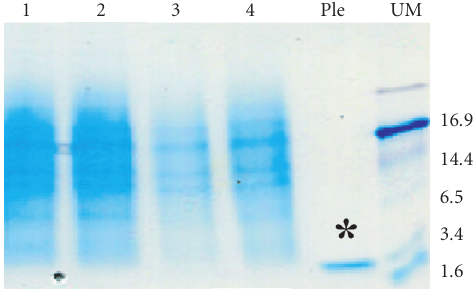
Figure 8. Western blot of synthetic pleurocidin (Ple) using anti- pleurocidin antibody. 1-2: induced expresision samples of Pichia pastoris X-33 (days 2 and 4). 3-4: induced expresision samples of P pastoris KM71H (days 4 and 6). UM ∗ ultra-low marker (pep- tide marker). Ple: pleurocidin (100 µ